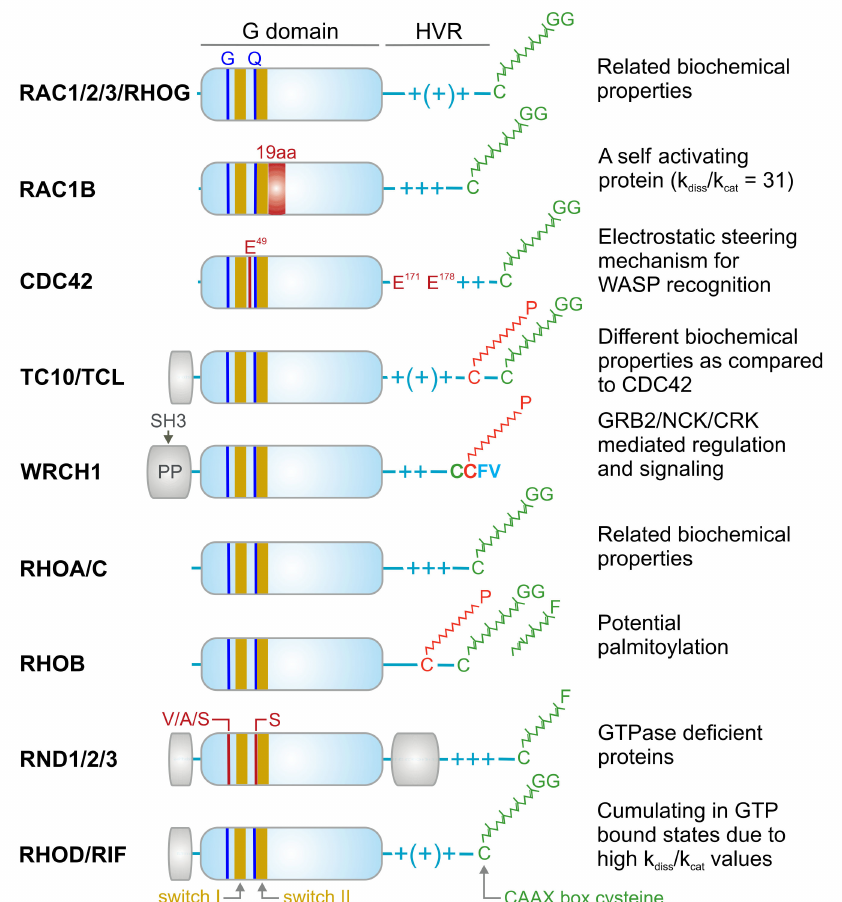
Figure 2. Domains, signature motifs, and post-translational modification of RHO GTPases. RHO GTPases contain a highly conserved G domain, which is responsible for GDP/GTP binding and GTP hydrolysis. Switch I and switch II regions are the consensus binding sites for GEFs, GAPs, GDIs, and effectors, and undergo conformational changes upon the nucleotide exchange and hydrolysis [3].